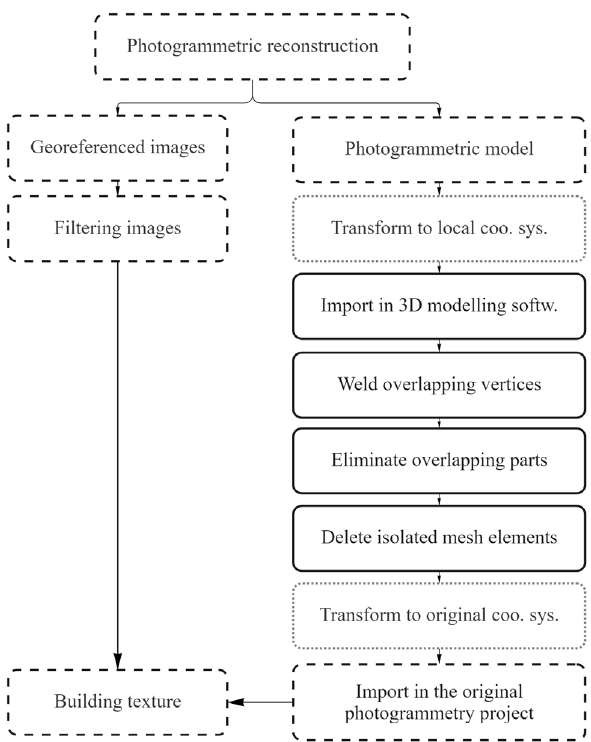
Figure 6. Workflow shows the main steps to improve the model geometry using 3D modelling software (continues line boxes)